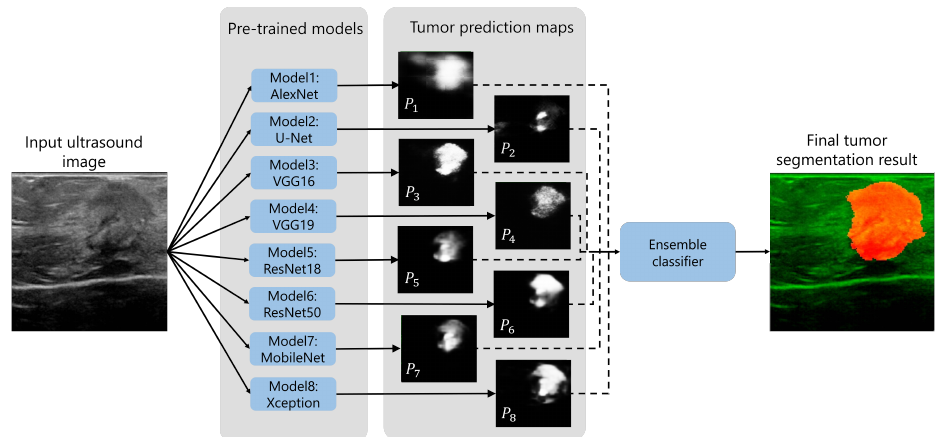
Figure 2. The described framework of ensemble learning for tumor segmentation in BCS-US images, using 8 models pre-trained on a public breast US data. In the output image, healthy tissue is highlighted in green, and tumor tissue is highlighted in